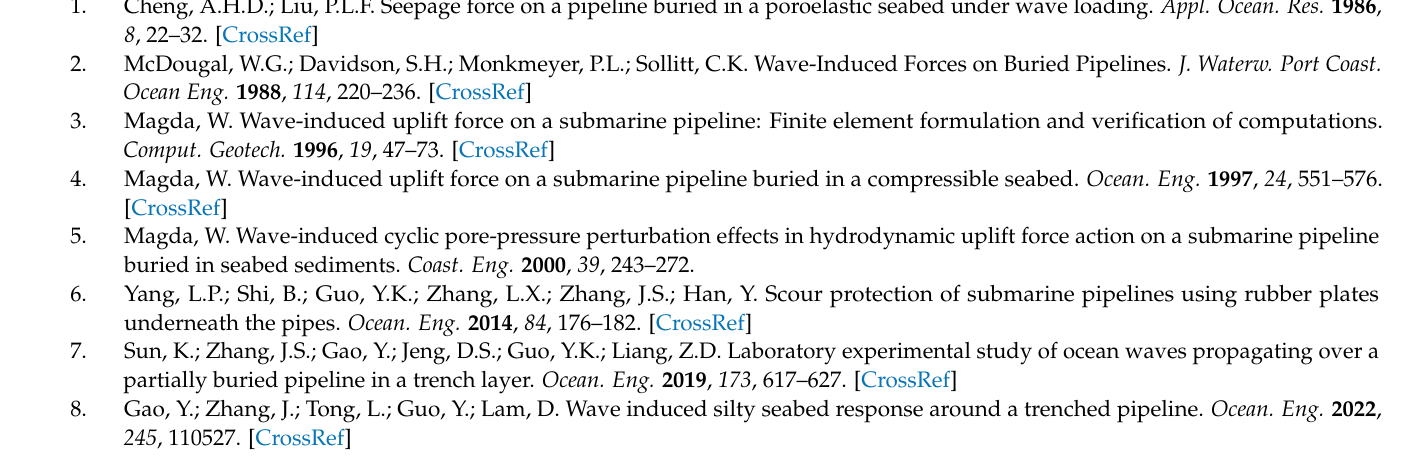
Figure A6. Variation of the dimensionless pore pressure amplitude around the pipeline under differ- ent current conditions within the medium sand and silt seabed. ( a ) d 50 = 0.30 mm; ( b ) d 50 = 0.045